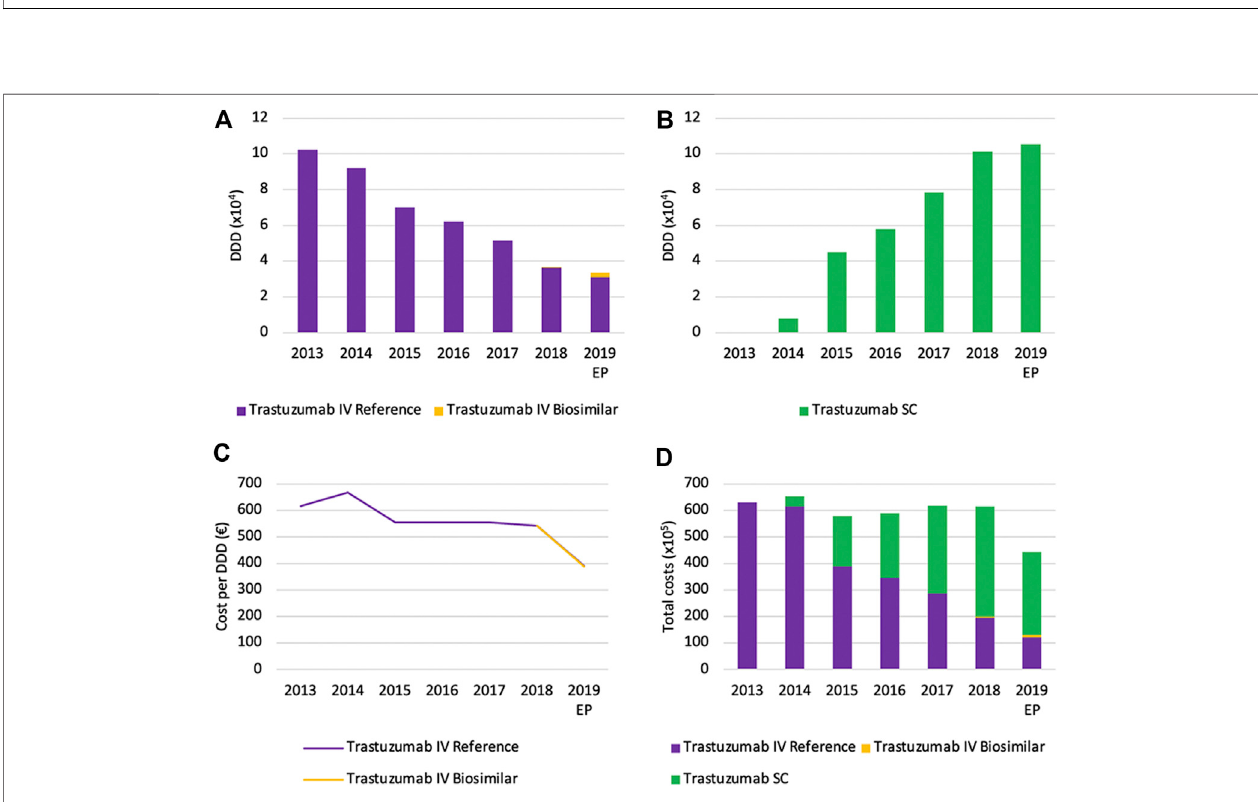
FIGURE 12 | Market data evolution of trastuzumab between 2013 and 2019. Total volume (DDD) evolution of IV trastuzumab (A) Total volume (DDD) evolution of SC trastuzumab ( B ) Daily cost ( € per DDD) of IV trastuzumab (C) Total cost ( € ) evolution of trastuzumab (D) . EP: Extrapolated data.